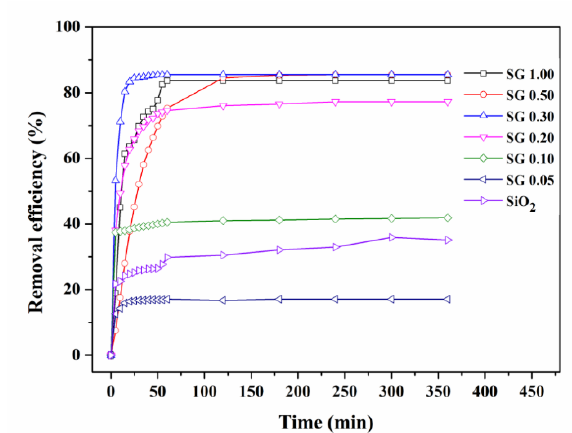
Figure 8. Effect of the ratio of GO and SiO 2 on the adsorption rate of NR (C 0 = 10 mg/L).